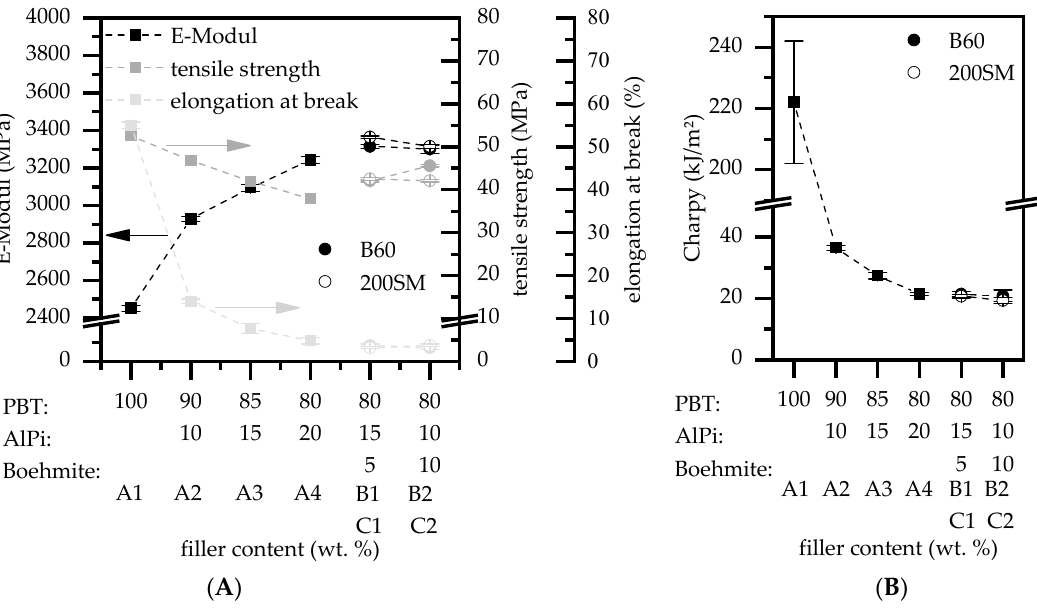
Figure 3. Mechanical properties of flame retardant modified poly(butadiene therepthalate) (PBT) filled at different filler contents of Aluminum tris-(diethylphosphinate) (AlPi) and boehmite mixtures. ( A ) Key figures of tensile tests and ( B ) impact bending tests.